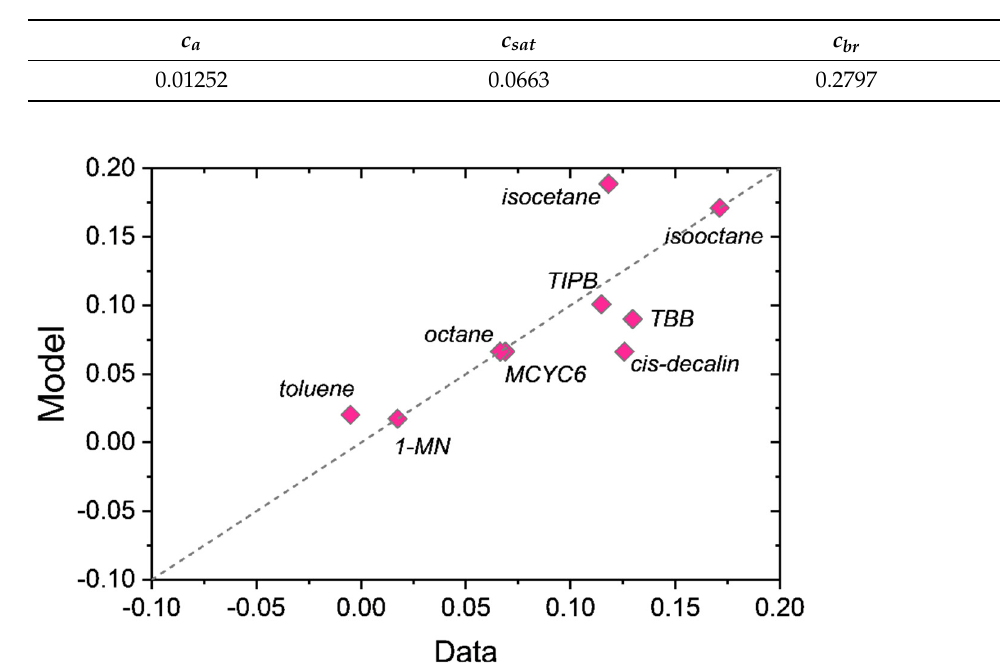
Table 5. Coefficients for the general binary interaction parameter model between hydrocarbons and SBAD-1.